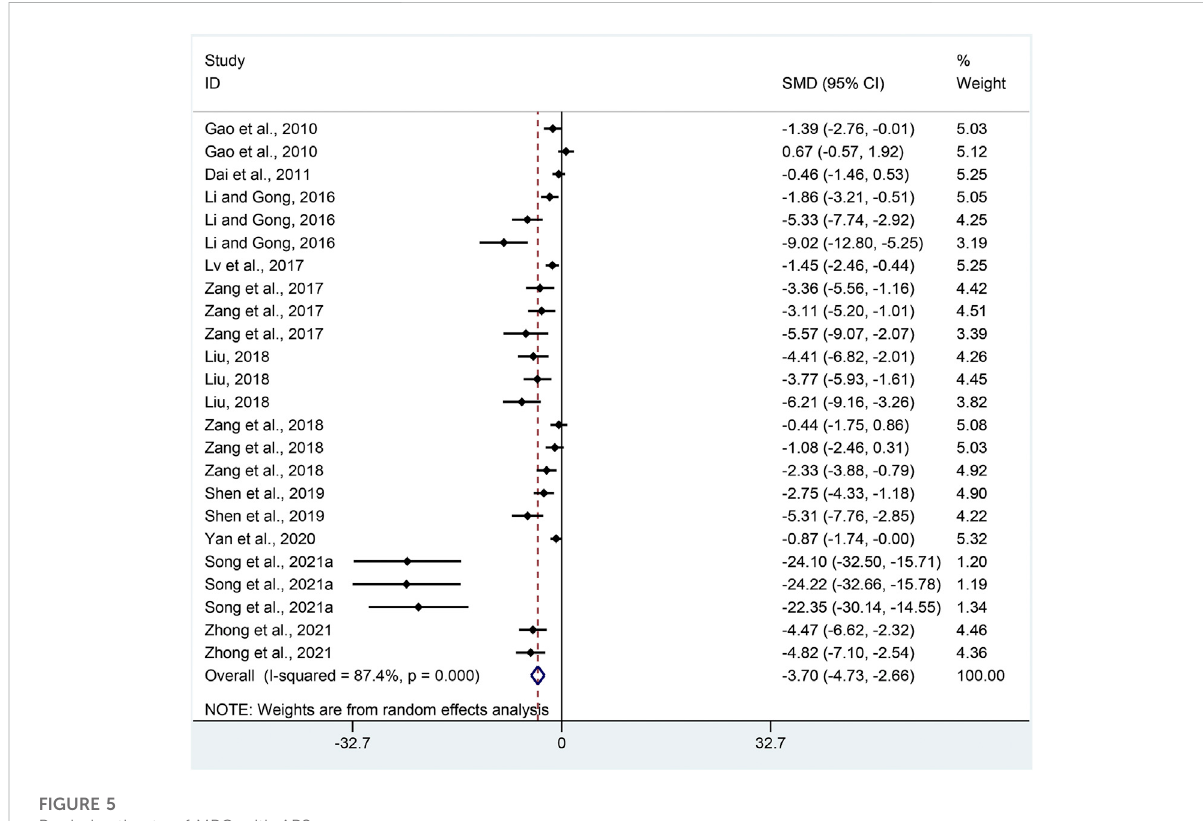
FIGURE 5 Pooled estimate of MPO with